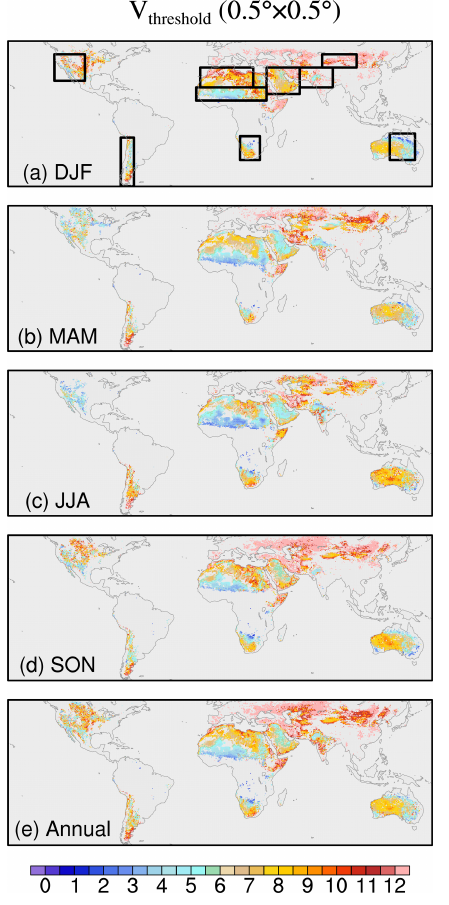
Figure 3. (a–e) Threshold of wind erosion ( V threshold ; unit: ms − 1 ) derived from satellite products and reanalyses for each season and the annual mean using DOD thresh = 0 . 5 (or 0.05). Black boxes in (a) denote nine dust source regions as listed in Table 1.